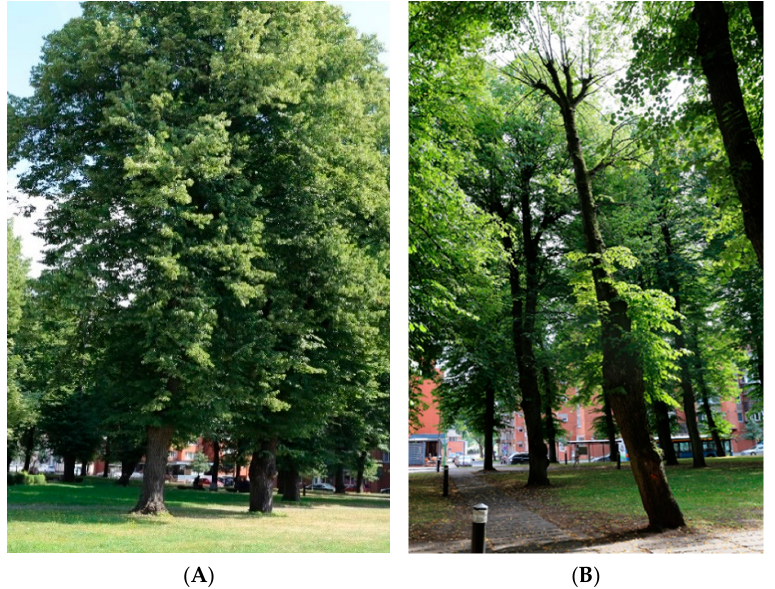
Figure 1. Examples of healthy and damaged trees in Donelaicio Park. ( A ) Healthy tree, Donelaicio Park. ( B ) Damaged tree, Donelaicio Park. (Photos: Aist ė Povilaitien ė )